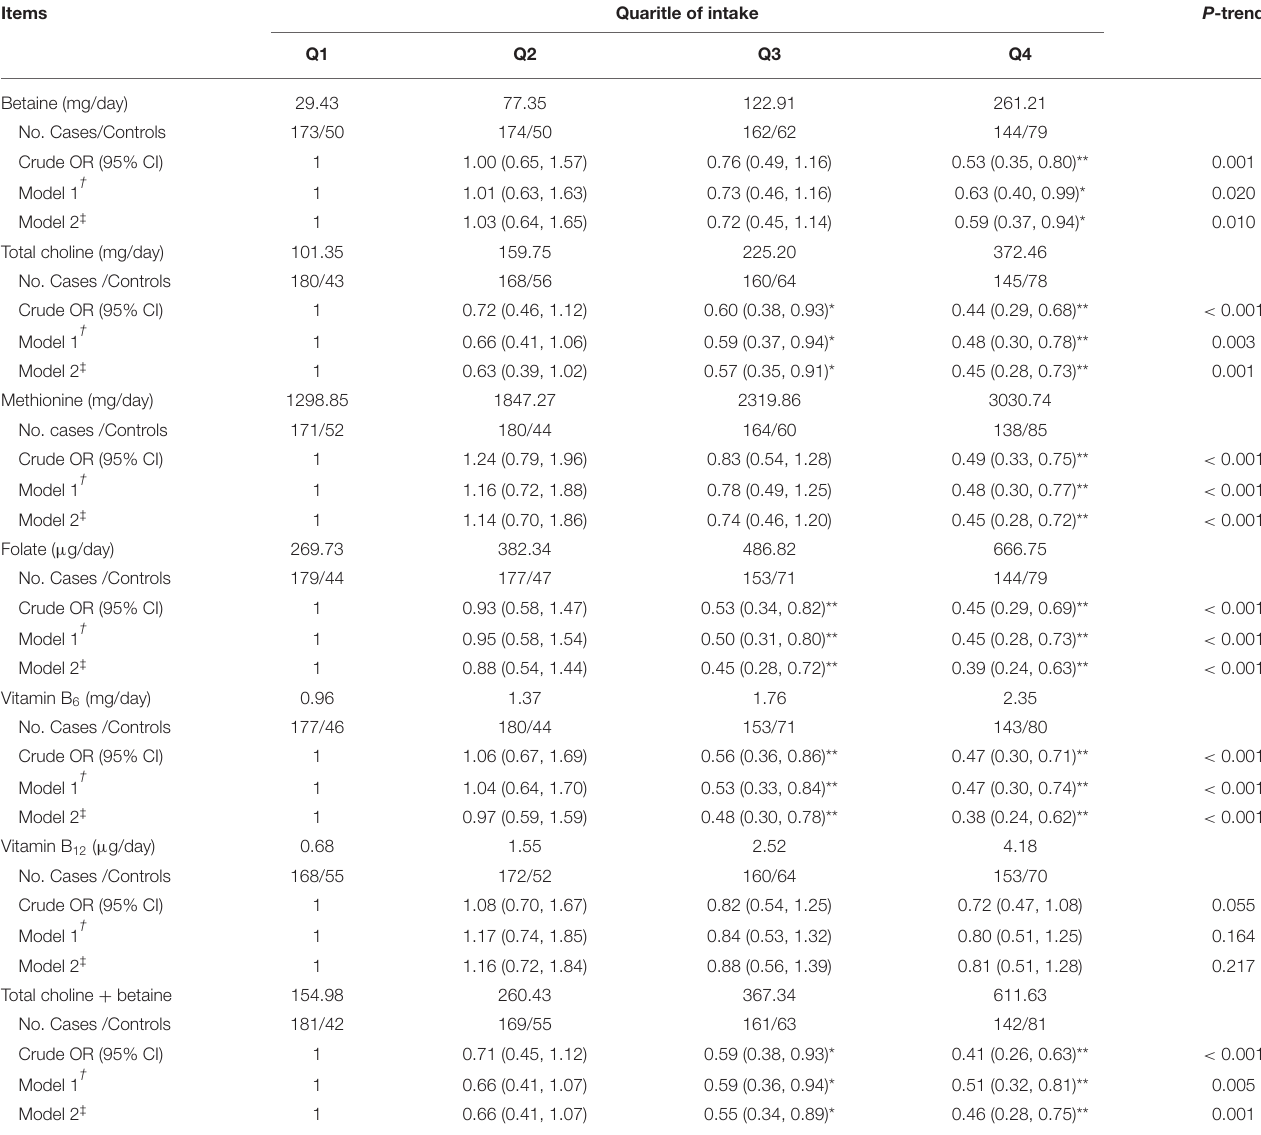
TABLE 3 | Odds ratios ( ORs ) and 95% CIs of fluorosis for quartiles of dietary energy-adjusted one-carbon metabolism-related nutrients intakes.